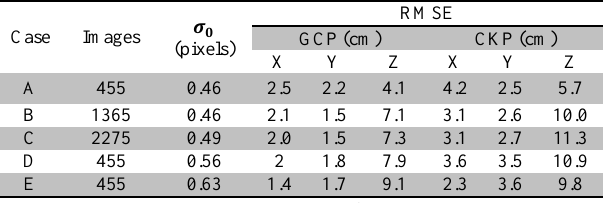
Table 4. Accuracy assessment of aerial